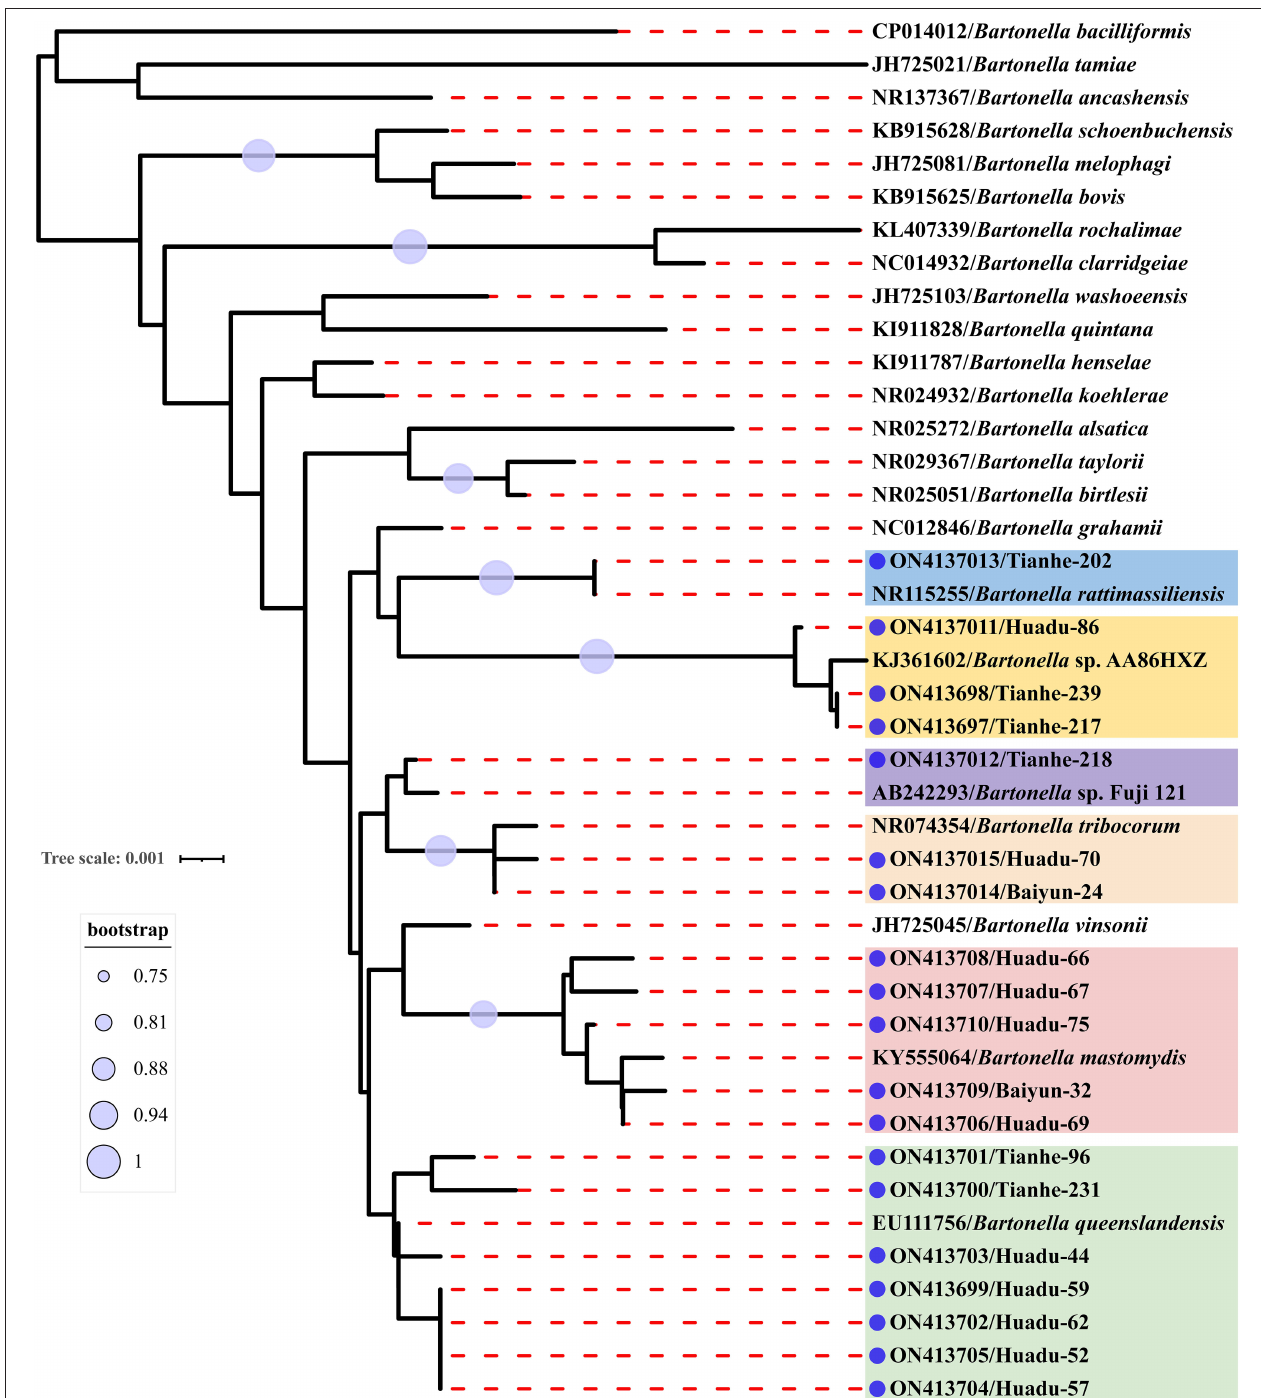
FIGURE 2 | Maximum-likelihood phylogenetic tree reconstructed based on the nucleotide sequences of rrs gene of Bartonella . Bootstrap values were calculated with 100 replicates of the alignment, and only bootstrap values > 70% are shown at appropriate nodes. Sequences of Bartonella determined in this study are marked with blue